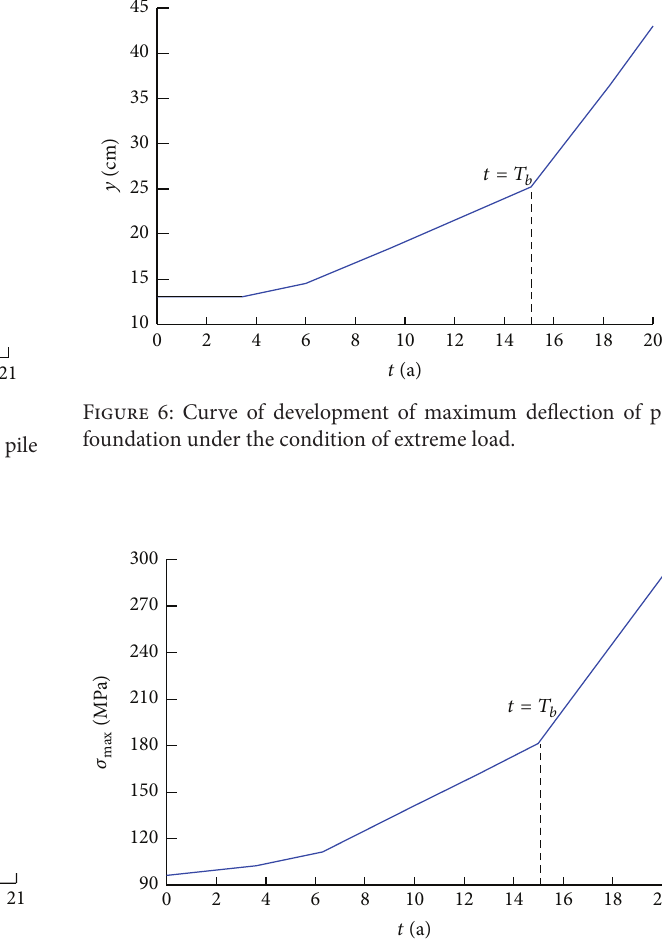
Figure 5: Curve of development of maximum stress of pile founda- tion under normal operation condition.